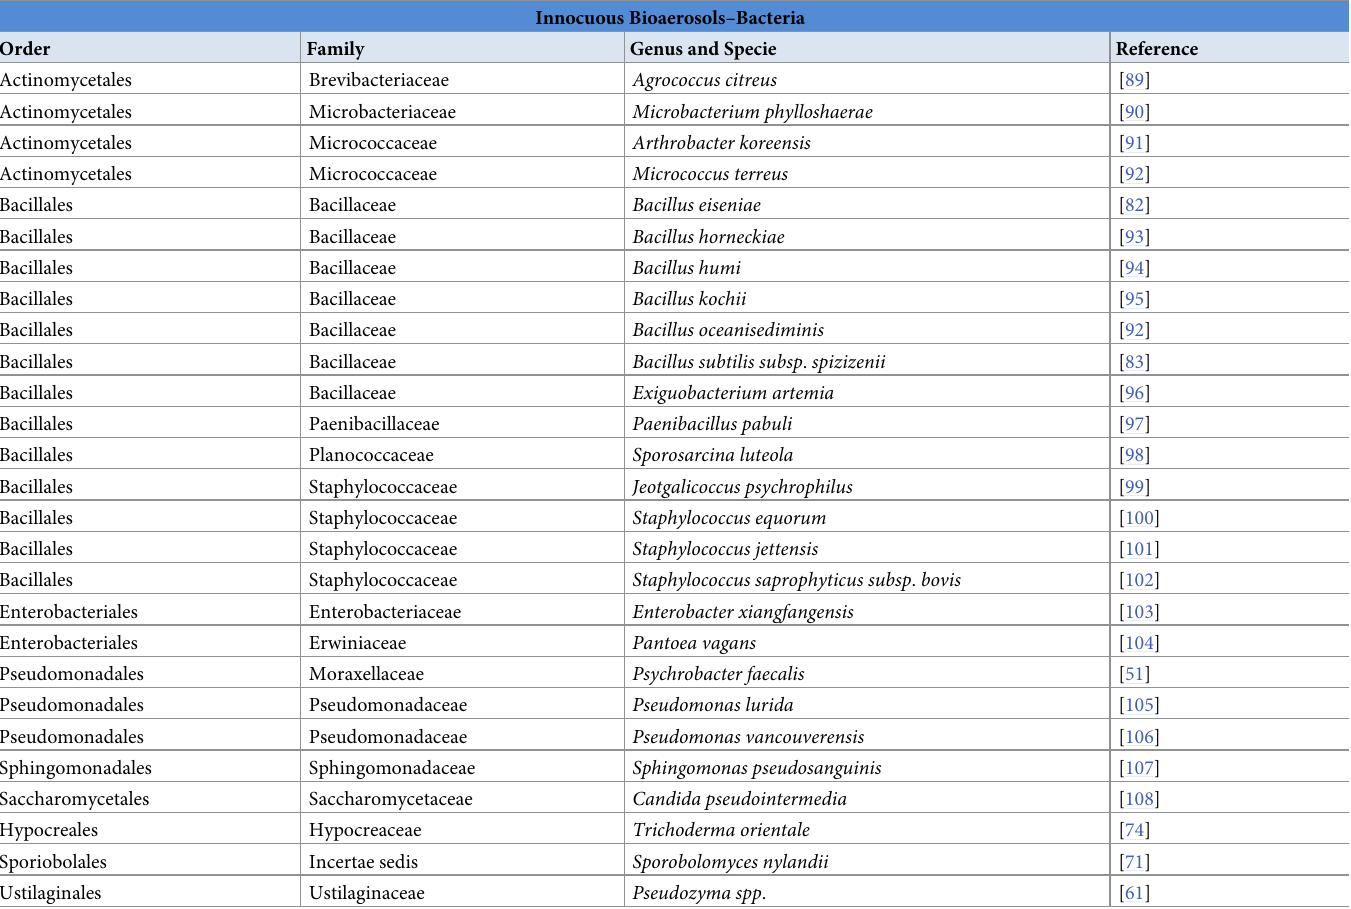
Table 2. Innocuous bioaerosols detected and classified alphabetically from order to